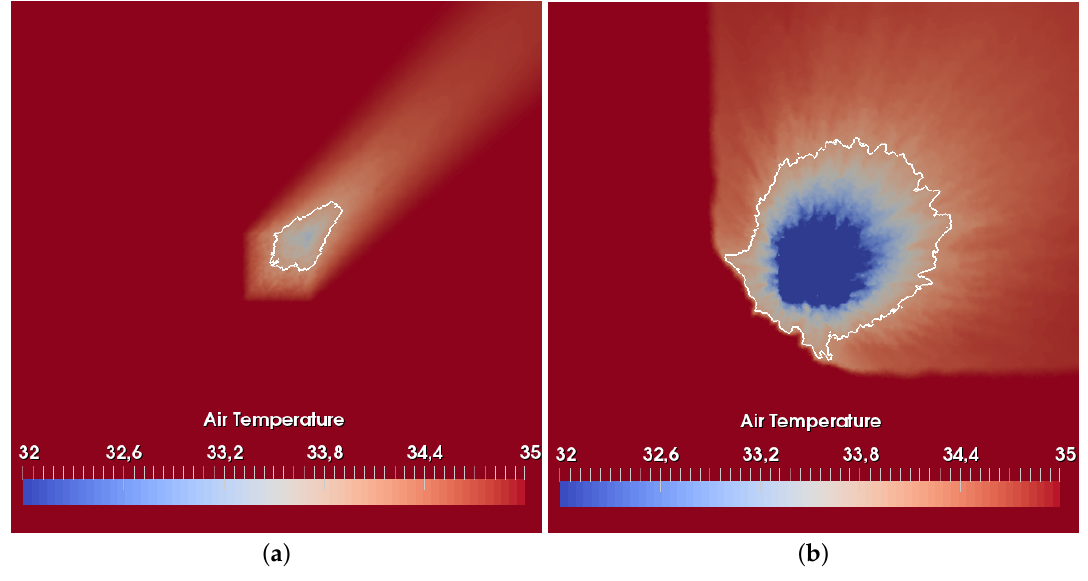
Figure 5. Two-meter-high air temperature distribution inside and around a park with a width of 125 m: ( a ) Exposed to a wind speed of 2 m/s; ( b ) Exposed to a wind speed of 0.5 m/s—the white line is the 34 °C